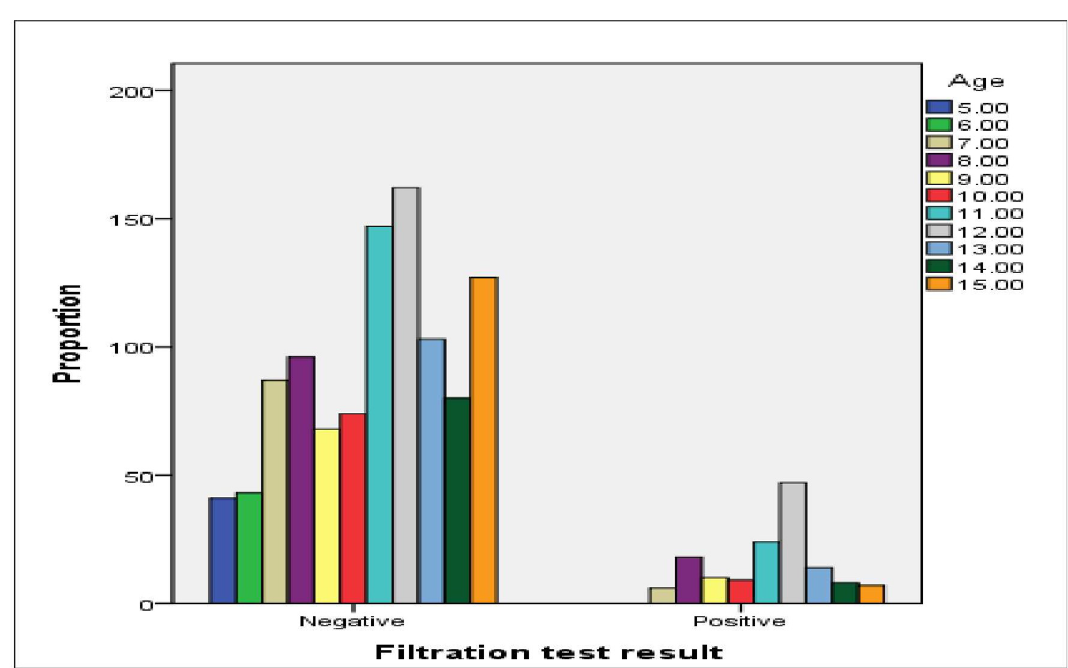
Fig 2. Prevalence of urogenital schistosomiasis by age (using urine filtration method).